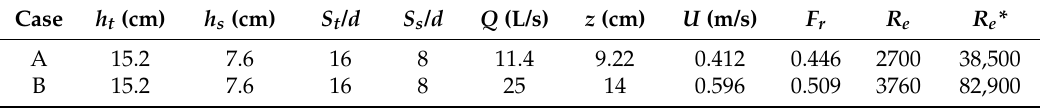
Reynolds number, and R e * is the flow Reynolds number.